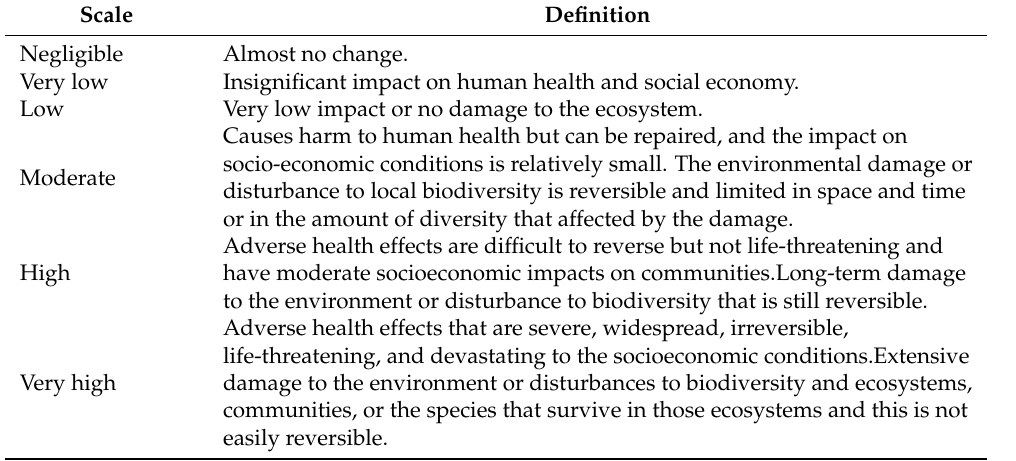
Table 3. The definition of each scale that may result from each identified hazard with the endpoint of causing more harm.